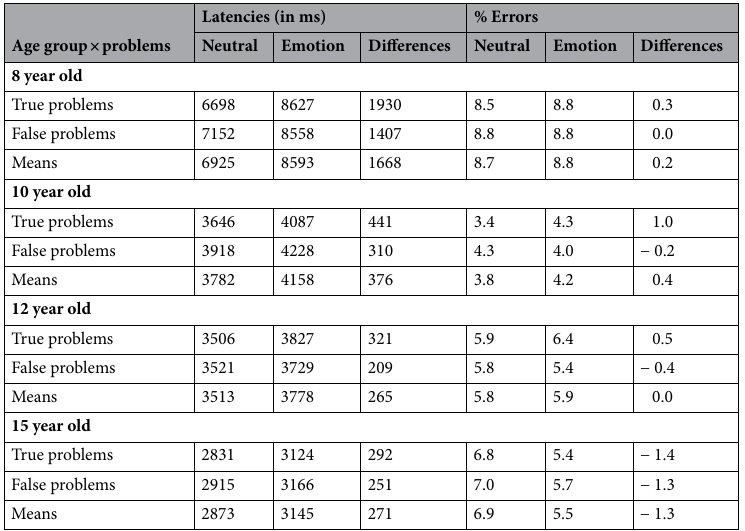
Table 1. Mean solution times and percentages of errors for true and false problems under neutral and emotion conditions as a function of children’s